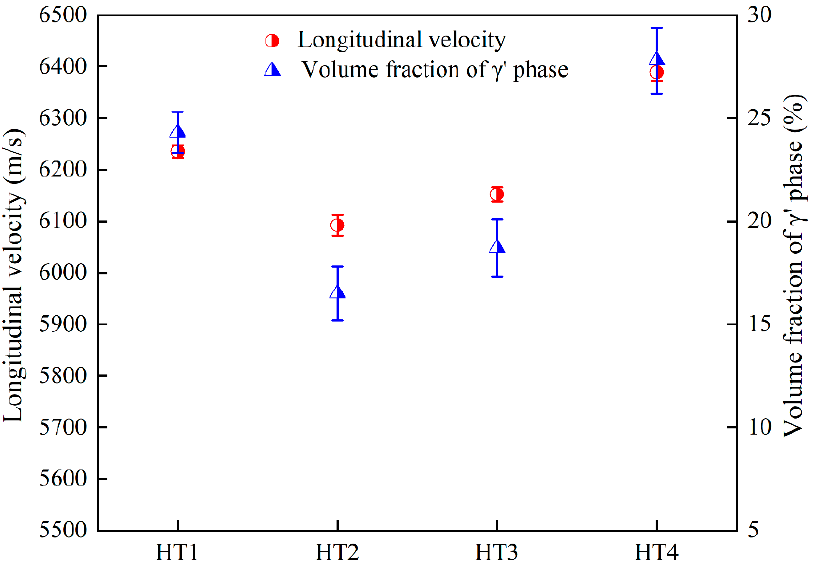
Figure 3. The variation trends in ultrasonic longitudinal velocity and volume fraction of the γ′ phase under various aging treatment conditions.